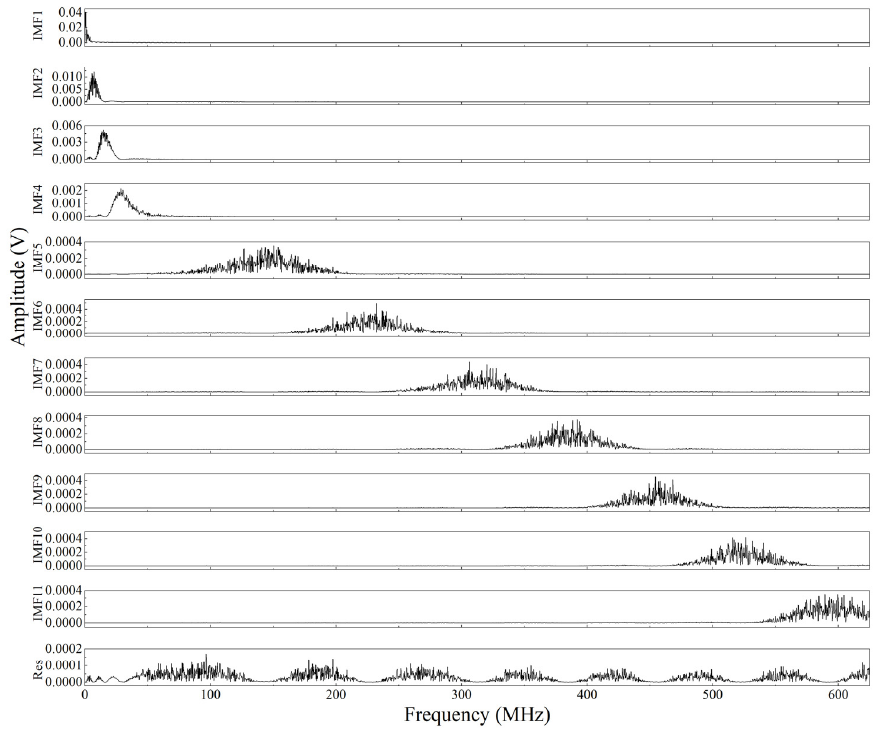
Figure 9. Fourier transform of the BLIMFs decomposed by the VMD method for the ultrasonic sig-